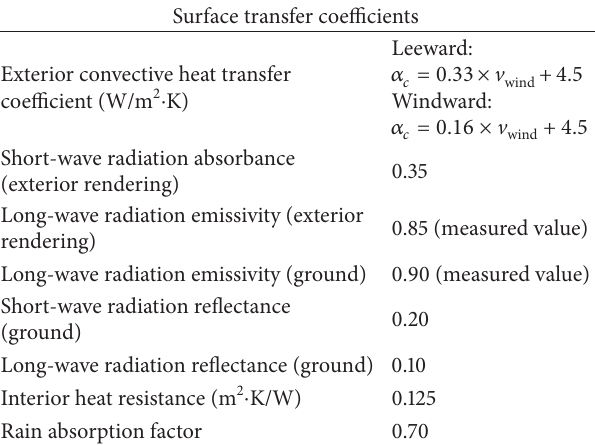
Table 3: Surface transfer coefficients in numerical